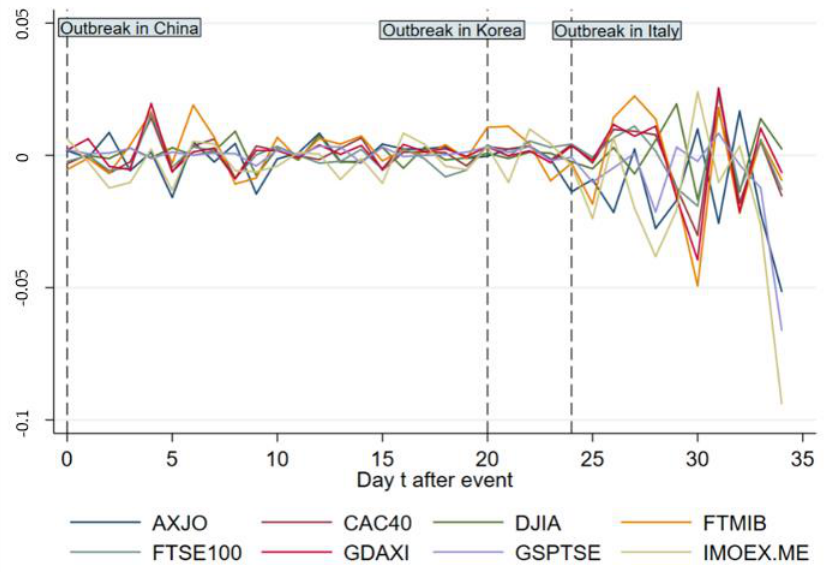
Figure 4. AR change of main indices out of Asia from day 0 to